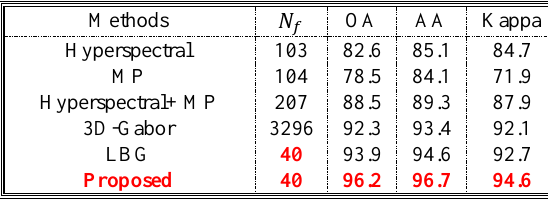
Table III. Describes the classification's parameters of this data.